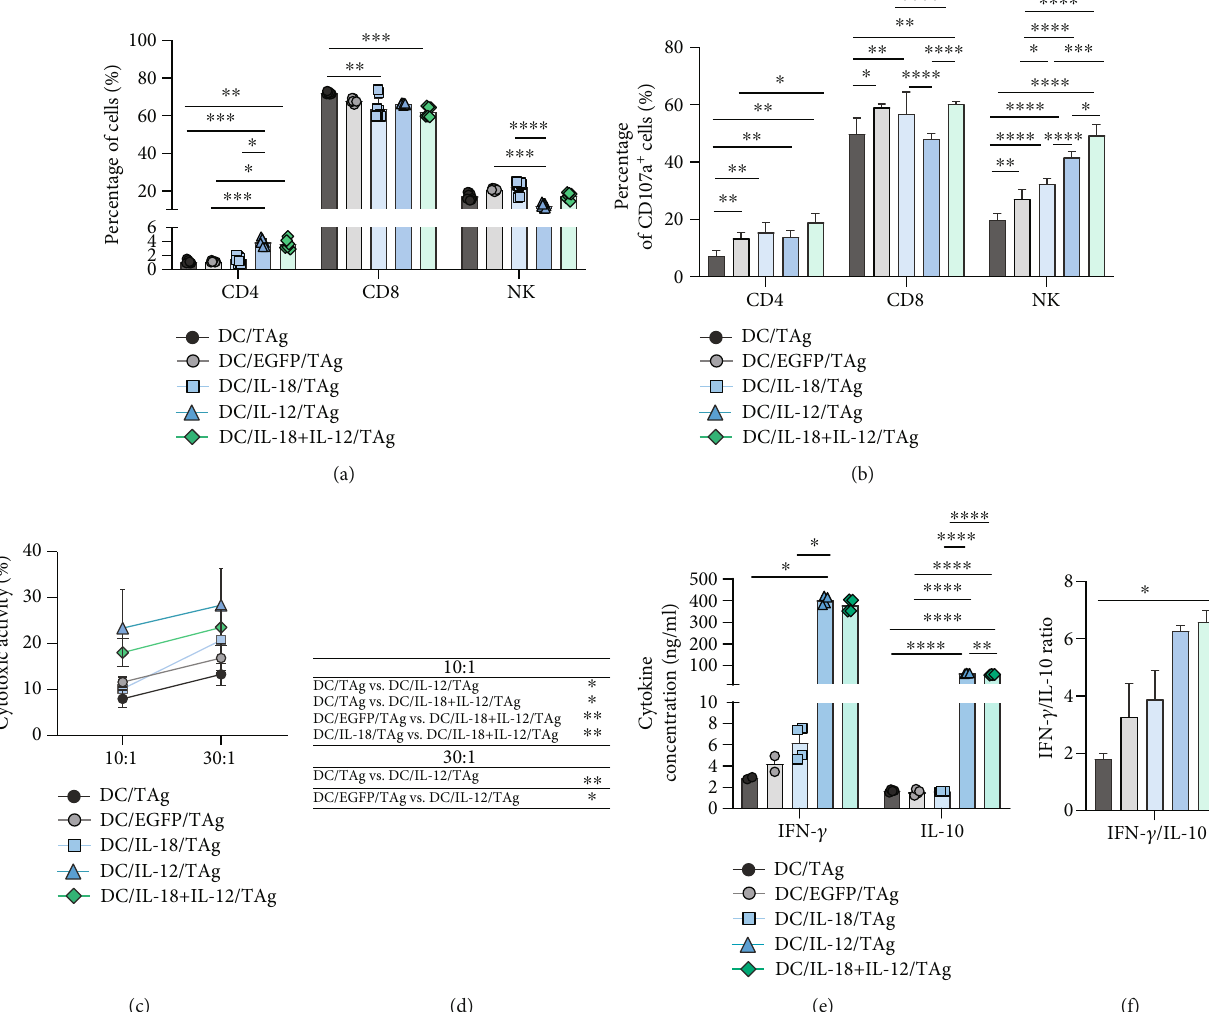
Figure 4: Splenocyte activity after primary stimulation with genetically modi fi ed DCs. (a) Phenotypic characteristics of spleen cells obtained after 5-day coculture with genetically modi fi ed DCs. (b) The percentage of e ff ector cells (CD107a + ) was determined among CD4 + , CD8 + T cells, and NK cells after 2-hour incubation with MC38 cells using fl ow cytometry. (c) The cytotoxic activity of splenic e ff ector cells is shown as the percentage of dead MC38 cells after 4-hour incubation with e ff ector cells in a ratio of 10:1 and 30: 1 E :T (e ff ector cells :MC38/0 target cells). The speci fi c killing of DiO and PI-labeled MC38 tumor cells was performed by fl ow cytometry. (d) Table of statistically signi fi cant changes in the cytotoxic activity of e ff ector splenocytes in a ratio of 10 :1 and 30:1 E :T, respectively. (e) Concentration of IFN- γ and IL-10 in supernatants collected after 5 days of coculture of genetically modi fi ed DCs with splenocytes was determined using ELISA. (f) The obtained results were additionally presented as the ratio of IFN- γ and IL-10 concentrations. Results are presented as mean + SD calculated for at least three repeats in two independent experiments. Di ff erences between groups were estimated using the nonparametric Kruskal-Wallis test followed by Dunn ’ s multiple comparison post hoc test ((a); (c) ratio 30 :1; (e) concentration of IFN- γ ; (f)) or the parametric Brown-Forsythe and Welch ANOVA test followed by Dunnett ’ s T3 multiple comparison post hoc test ((b); (c) ratio 10 :1; (e) concentration of IL-10) ( ∗ p < 0 : 05 , ∗∗ p < 0 : 01 , ∗∗∗ p < 0 : 001 , ∗∗∗∗ p < 0 : 0001